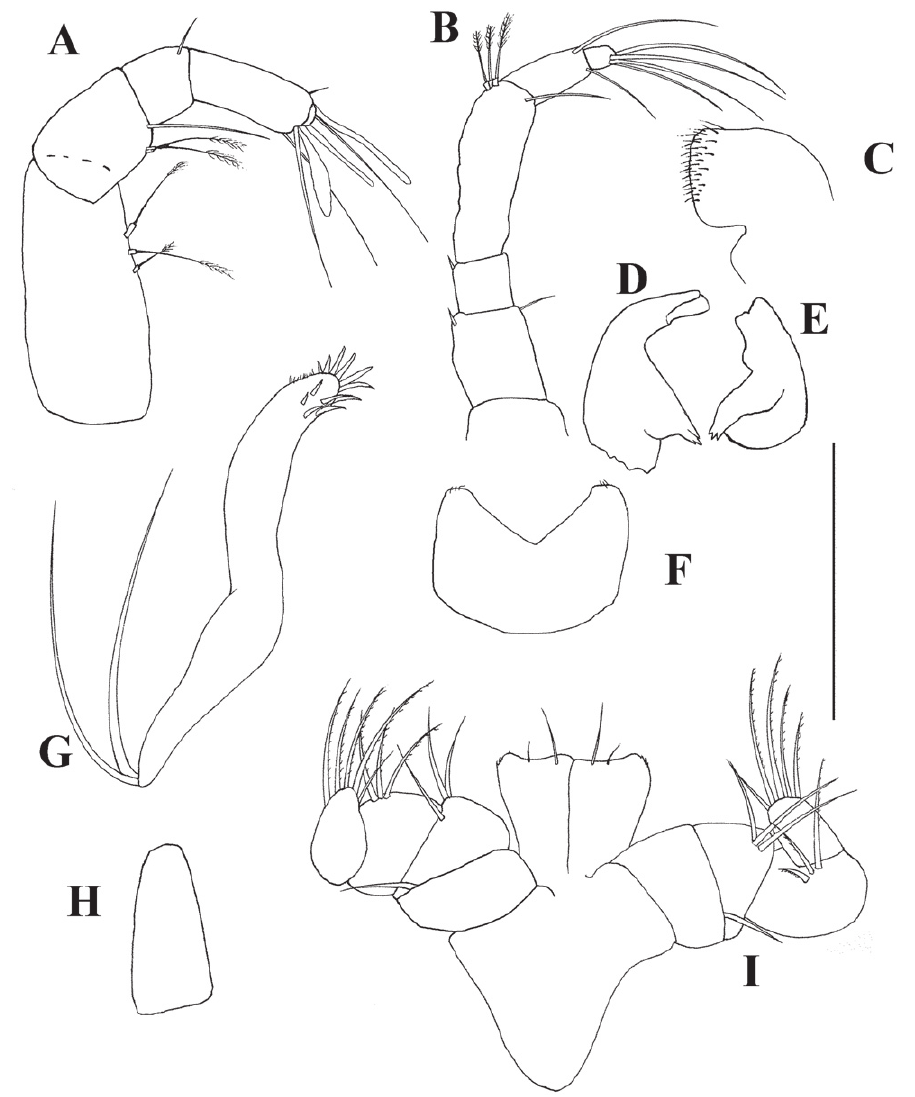
Figure 9. Robustochelia pacifi ca sp. n. Holotype A antennule B antenna C labrum D left mandible E right mandible F labium G maxillule H maxilla I Maxilliped. Scale bar 0.1 mm.